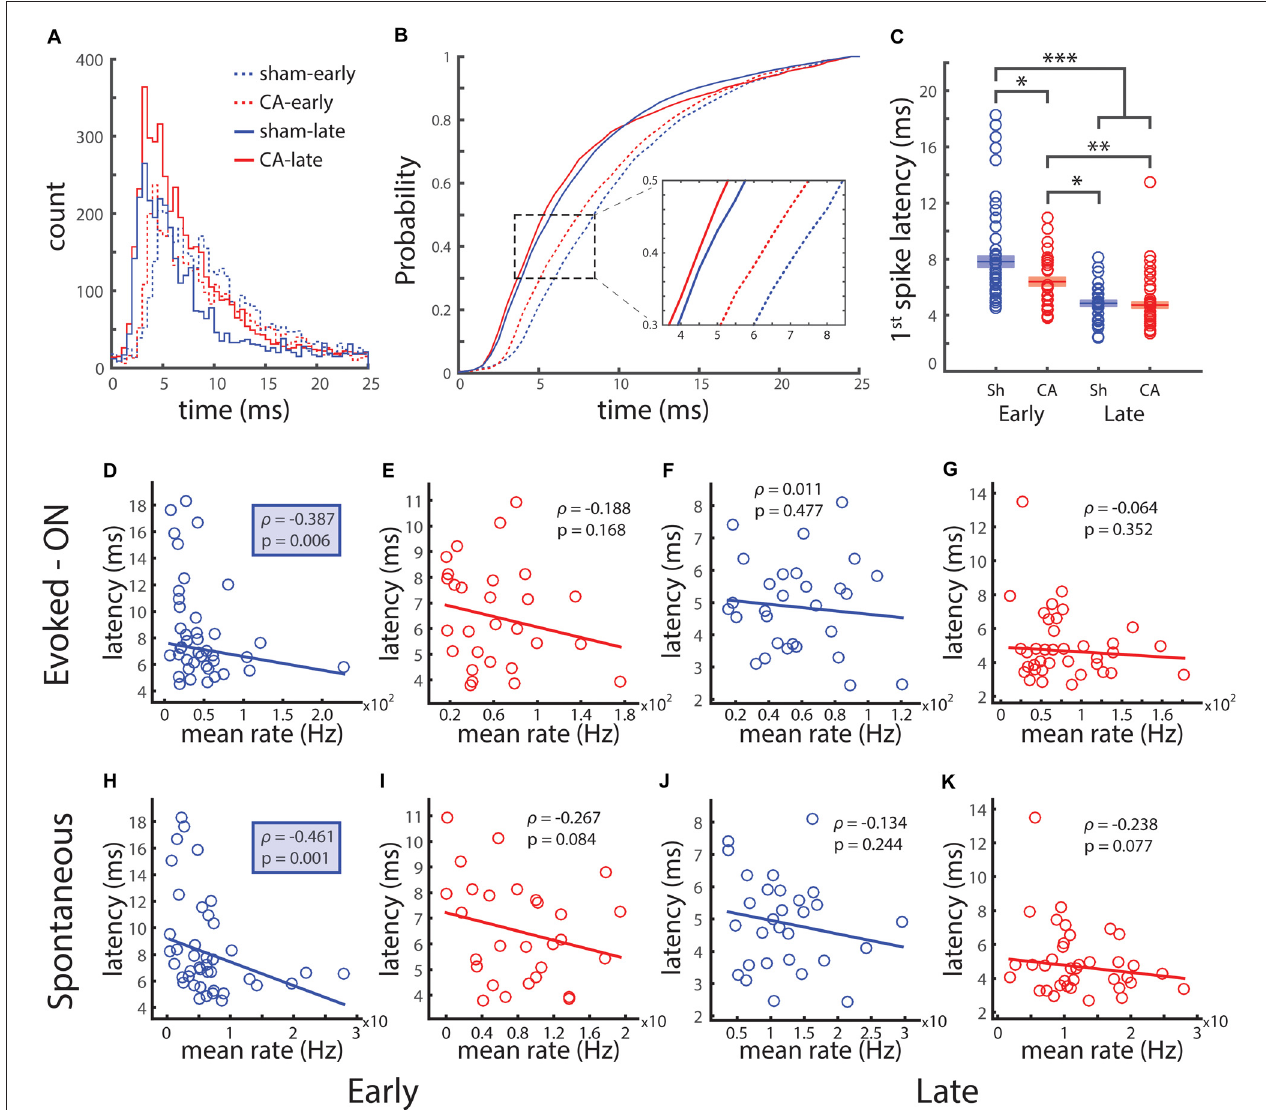
FIGURE 5 | Spike timing of whisker-evoked responses depends on development and is affected by ischemic injury. (A) PSTHs for the 25 ms whisker deflection ON period. (B) The cumulative distribution of spike times during the 25 ms ON period. Zoom: the population average time to 40% of spikes shows that the same proportion of spikes occurs earlier for late groups compared to early groups and for CA-early compared to sham-early. (C) The latency between whisker deflection onset and the first spike in trials with non-zero response is significantly longer for sham-early vs. all other groups, and CA-early vs. late groups. (D) The first spike latency and evoked spike count is negatively correlated for the early sham group. (E–G) First spike latency and evoked count are uncorrelated for CA-early and both late groups. (H) First spike latency and spontaneous spike count are negatively correlated for sham-early rats. (I–K) First spike latency and spontaneous spike count are not significantly correlated for early CA and both late groups. ∗ Indicates p < 0.05, ∗∗ indicates p < 0.01 and ∗∗∗ indicates p <